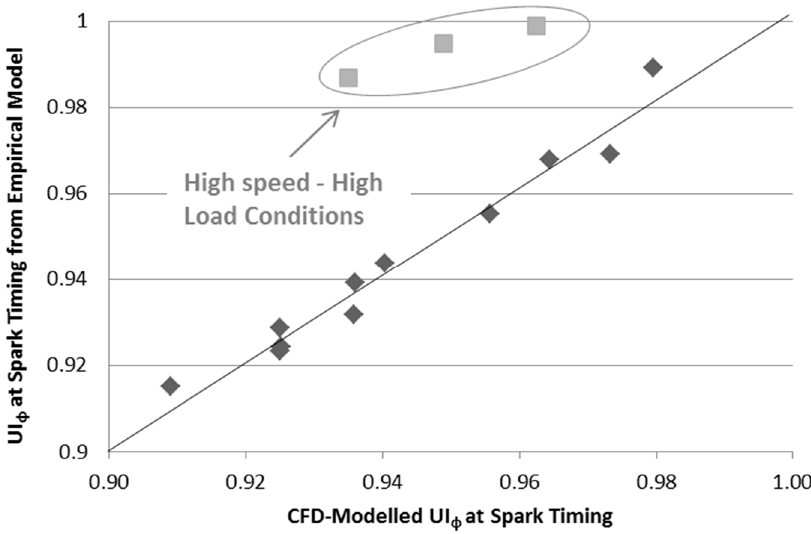
Figure 12. Comparison between CFD-modelled and empirical levels of charge homogeneity (uniformity index of equivalent ratio) at spark timing.